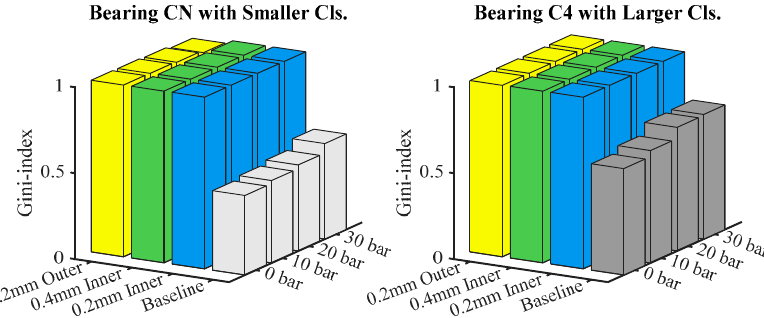
Figure 14. MSB-Gini Index for different clearances and different local faults under different loads.